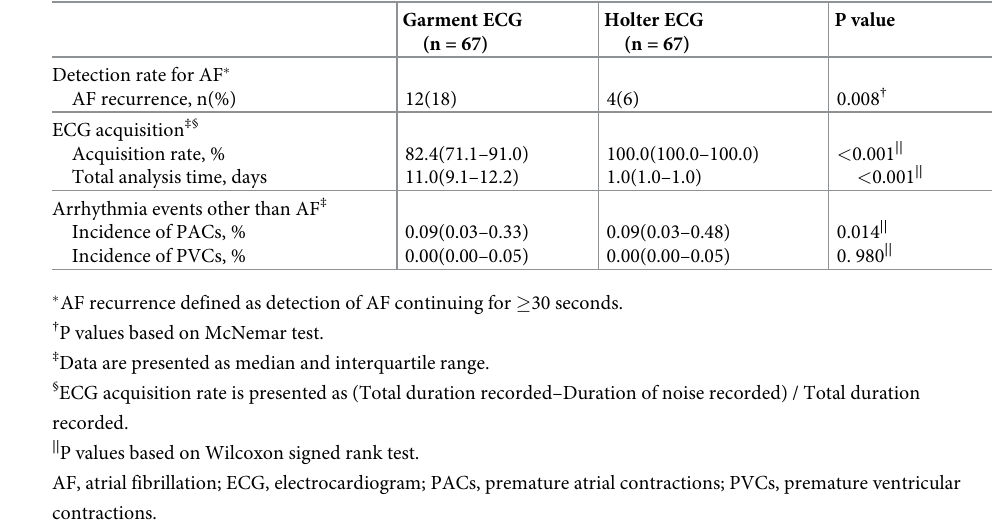
Table 2. Primary and secondary endpoint